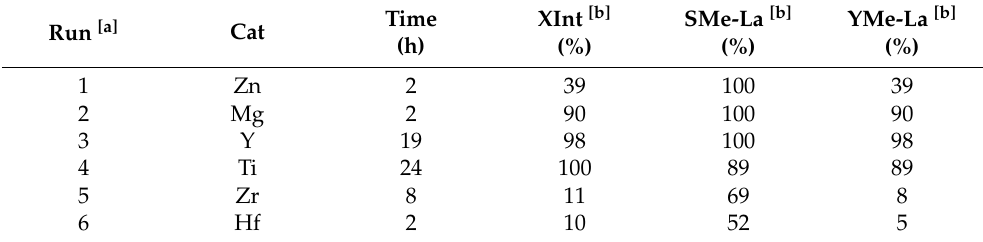
Table 1. Methanolysis of PLLA using metal amides.